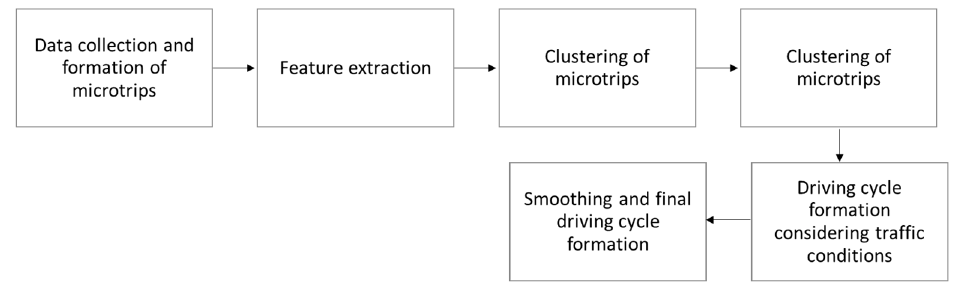
Figure 11. Overview of EV clustering based on microsegmentation proposed in [63].